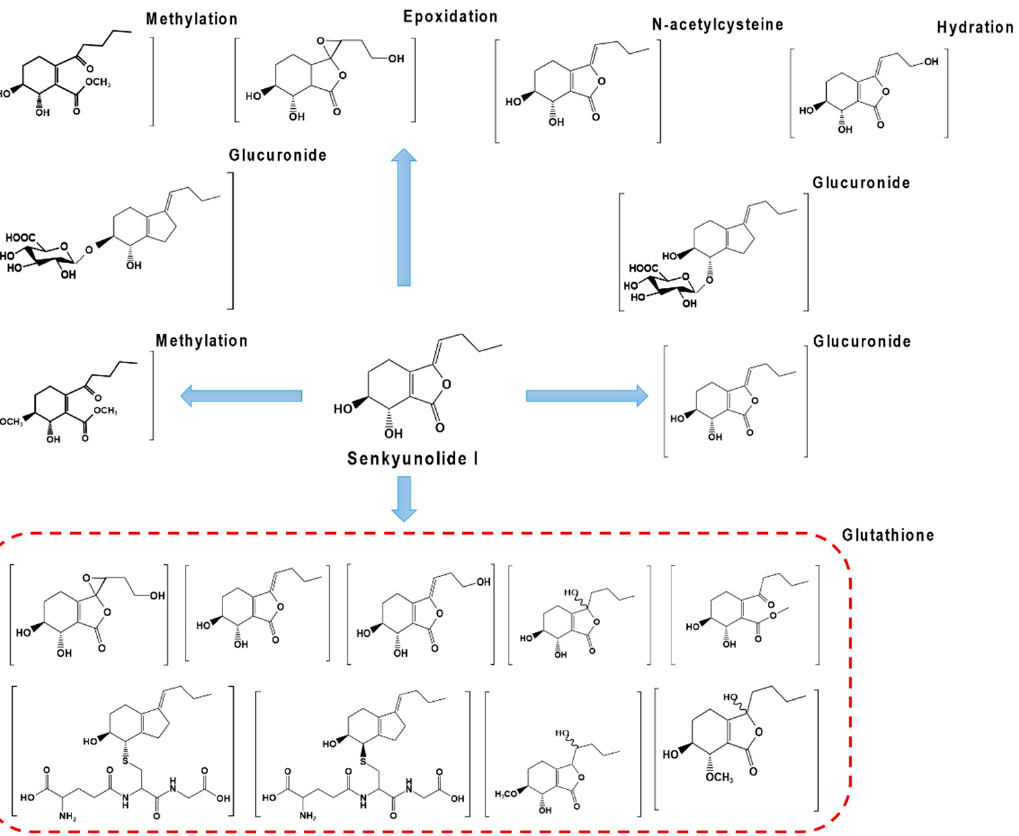
Figure 5. Main metabolic pathways of SI in vivo . The main metabolic reactions and proposed metabolites of SI, including G-SH: glutathione; glucuronide; N-acetylcysteine; methylation; epoxidation; hydration. Figure 5 is referenced by [35,40,92].